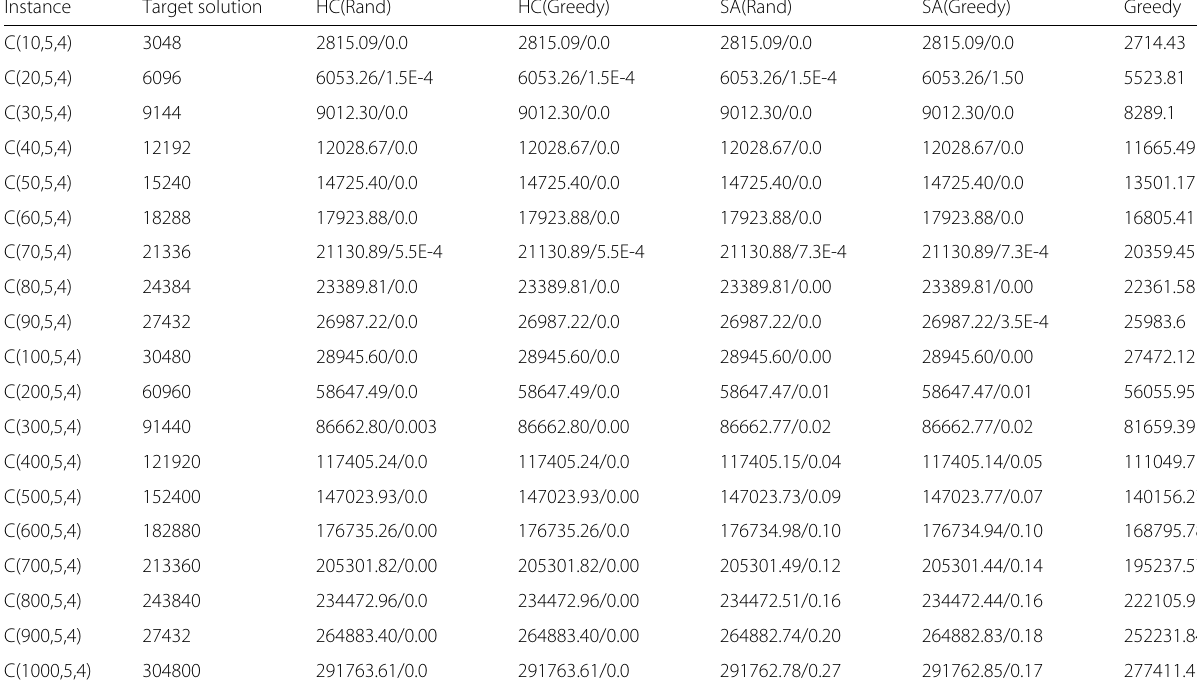
Table 5 Optimal values and standard deviation of different instances(l=5)